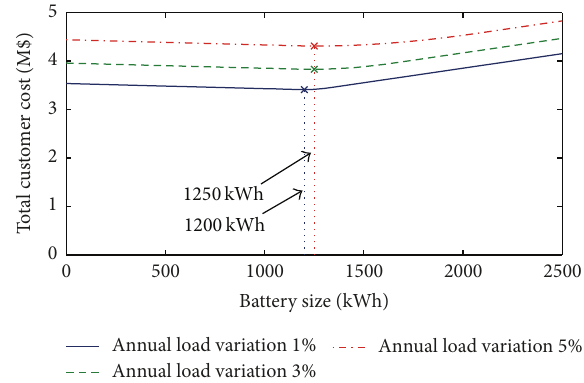
= 95 %, and Figure 9: Total customer cost with 𝛼 = 5 %, 𝛽 = 5 %, and 5% annual ch load variation and different values of BESS efficiency (industrial